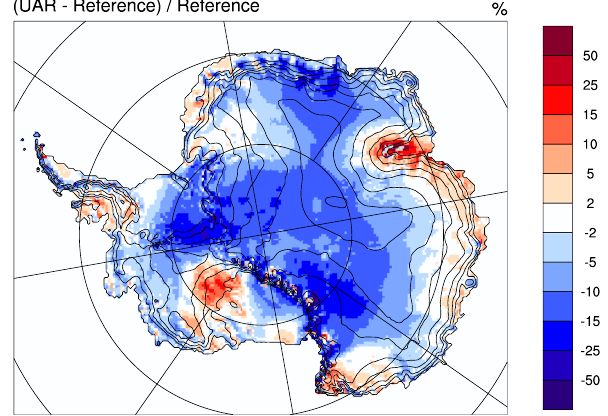
Figure 3. Difference in SMB (%) between the UAR and refer- ence RACMO2 simulation for 1979–2013. Grid points with neg- ative SMB in the reference simulation are masked grey.